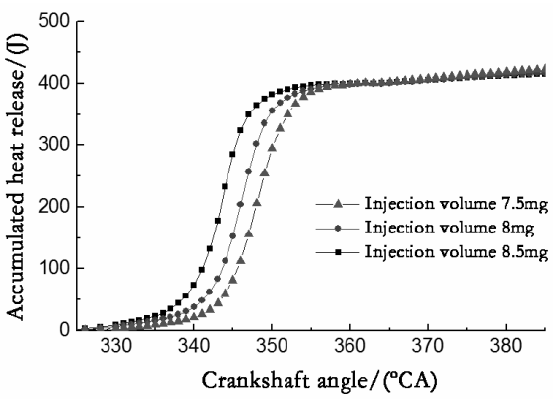
Figure 24. Cumulative heat release of different fuel injection volumes.